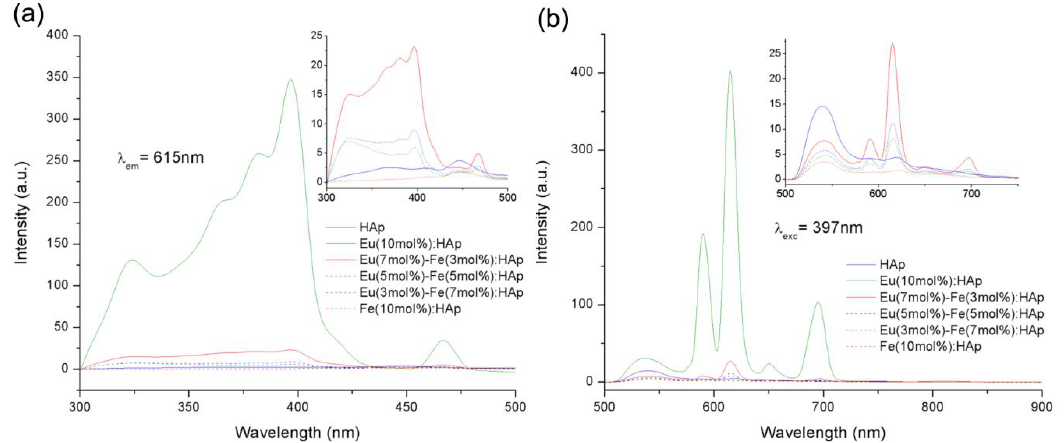
Figure 12. ( a ) The PL (photoluminescence) excitation spectra and ( b ) PL emission spectra [38]